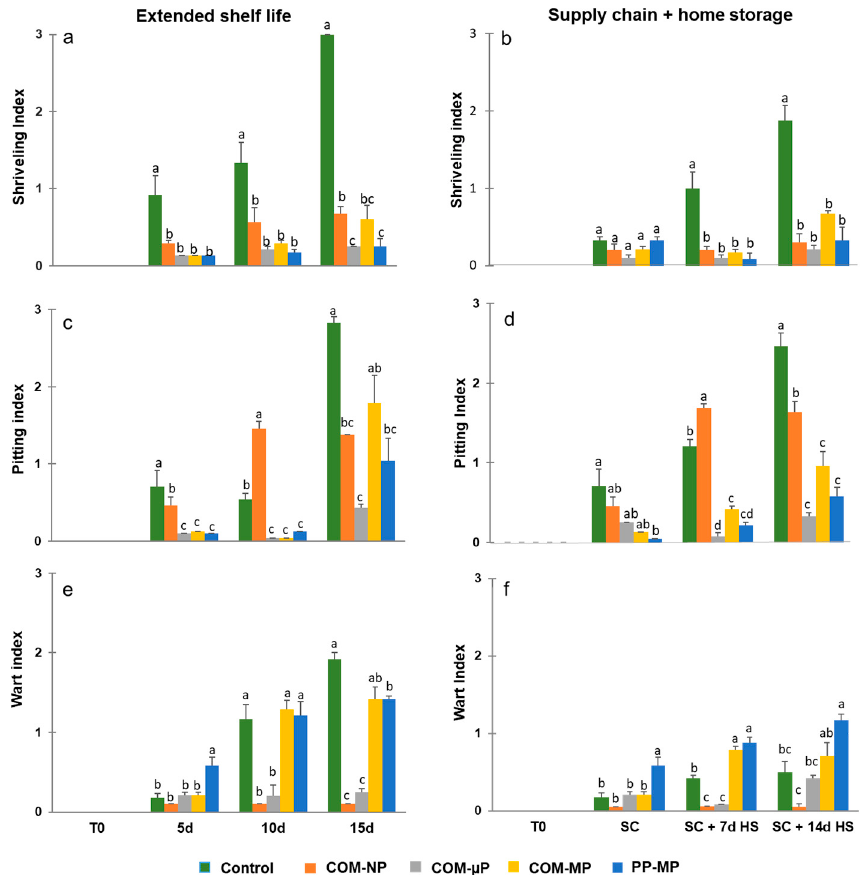
Figure 6. Shriveling, pitting, and wart indices of cucumbers stored in different types of packaging. Measurements were taken during continuous storage under shelf conditions at 22 ◦ C (Extended shelf life), and after the simulated farm-to-fork supply-chain treatment (2 days at 15 ◦ C + 2 days at 22 ◦ C) plus 1 or 2 weeks of refrigerated home storage at 4 ◦ C (Supply chain + home storage). Figures ( a ) and ( b ) represent shriveling indices; Figures ( c ) and ( d ) represent pitting indices, and Figures ( e ) and ( f ) represent wart indices after extended shelf life and farm-to-fork supply-chain conditions, respectively. Data are means ± SE of 3 replications. Different letters indicate significant differences at p ≤ 0.05. COM—compostable, PP—polypropylene, µ P—micro-perforated, MP—macro- perforated, NP—non-perforated.